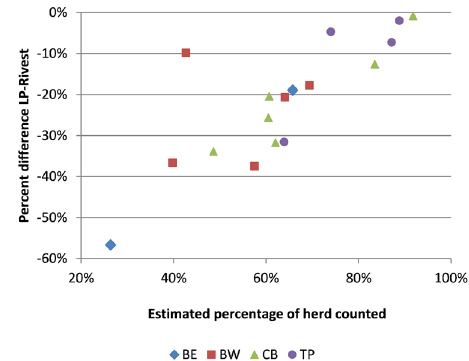
Figure 6. Comparison of difference between Lincoln Peterson and Rivest estimates ((LP estimate-Rivest estimate)/Rivest estimate) as a function of estimated proportion counted (total caribou counted/Rivest herd size estimate) for post-calving surveys of cari- bou herds in the Northwest Territories and Nunavut, Canada, 2000-2015. Estimates are displayed from the Bluenose-East (BE), Bluenose-West (BW), Cape Bathurst (CB) and Tuktoyaktuk Peninsula (TP)